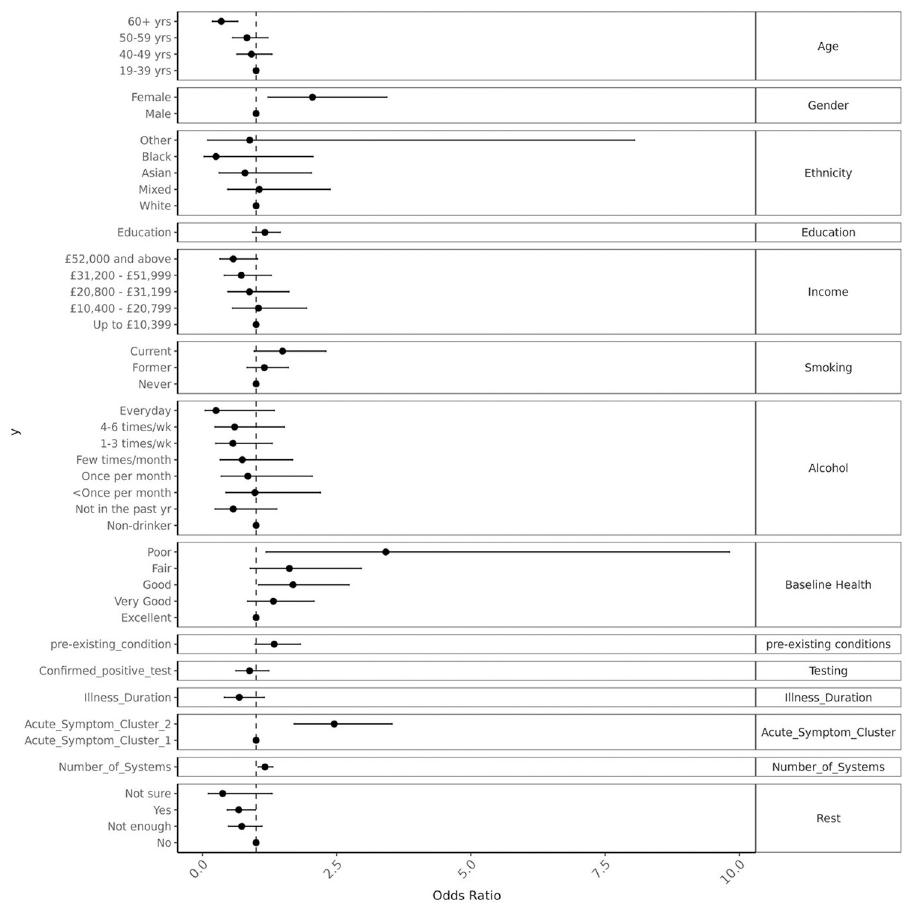
Fig 4. Adjusted associations with developing multisystem ongoing symptom cluster (OSC)